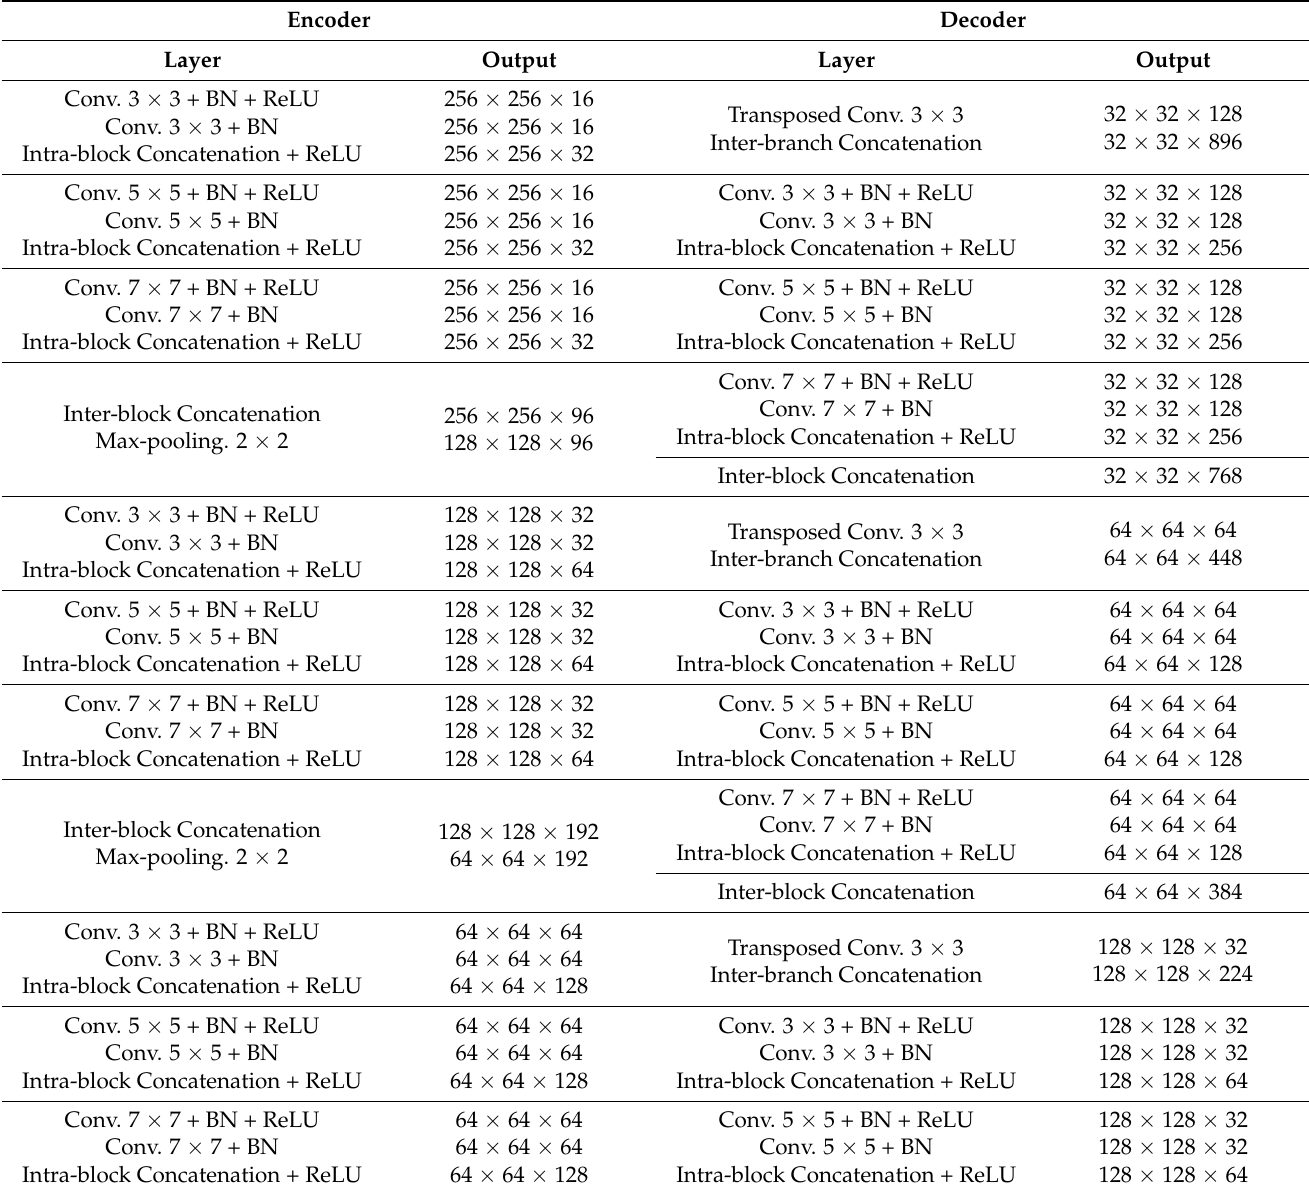
Table 2. MultiScale-Net